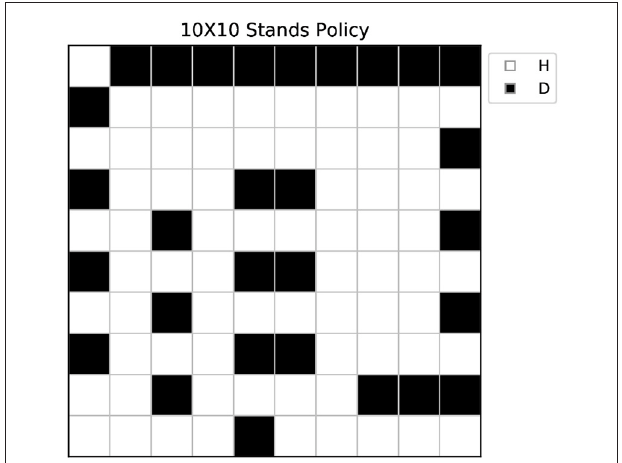
FIGURE 9 | Obtained DRL solution for the 100 with the GA obtained value.